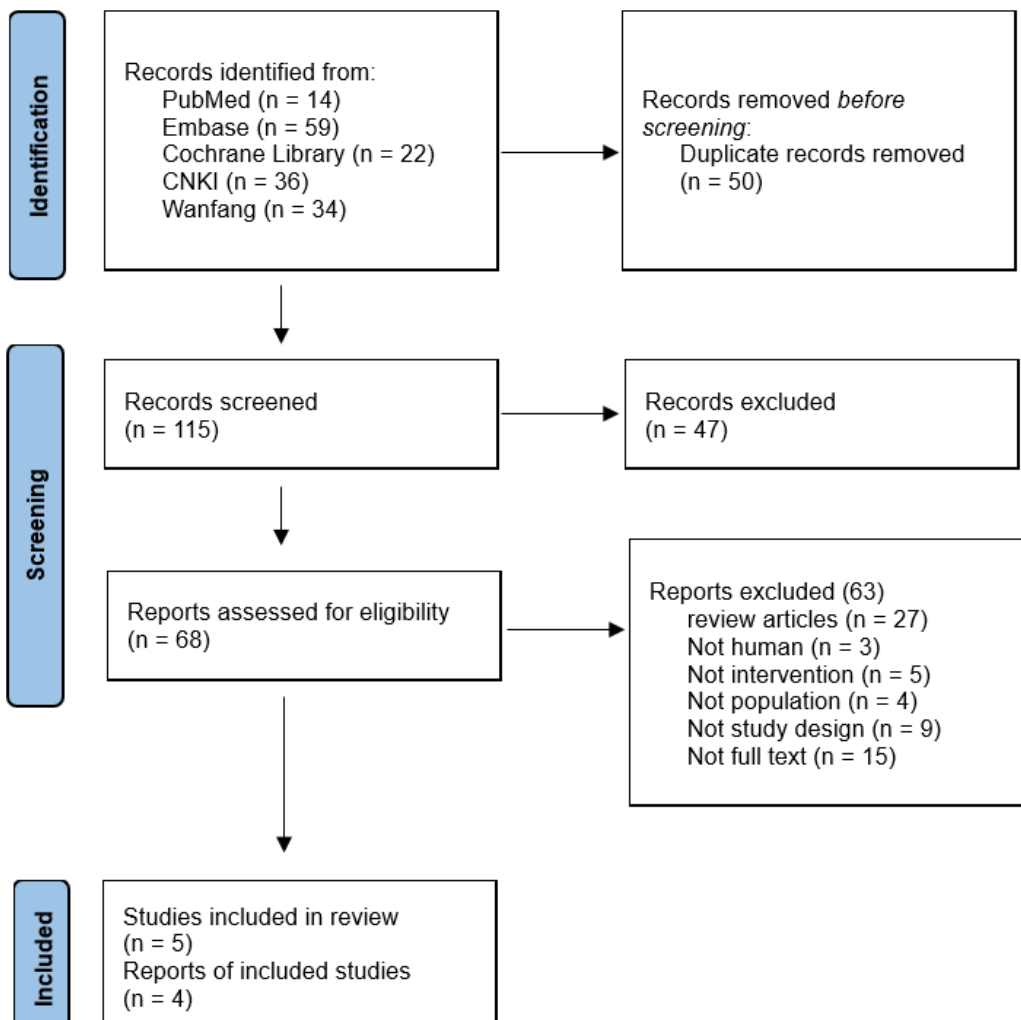
Figure 1. Flow diagram of study selection.